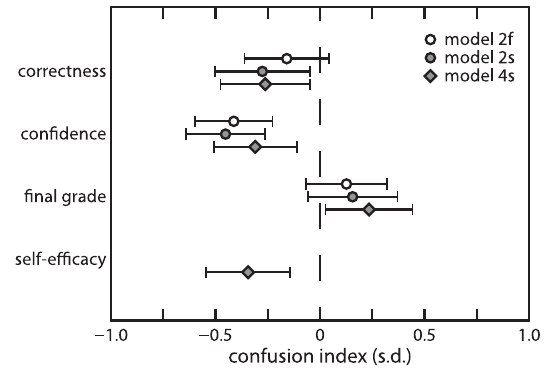
FIG. 2. Fitted linear regression models explaining variation in confusion index by selected variables of student learning and engagement. Models 2 f , 2 s , and 4 s are displayed here, where the letters f and s represent fall and spring semesters, respectively. The bars represent the 95% confidence interval around each of the mean values; if the confidence interval does not overlap the “ zero line, ” then the difference is statistically significant at the p ¼ 0 . 05 level.